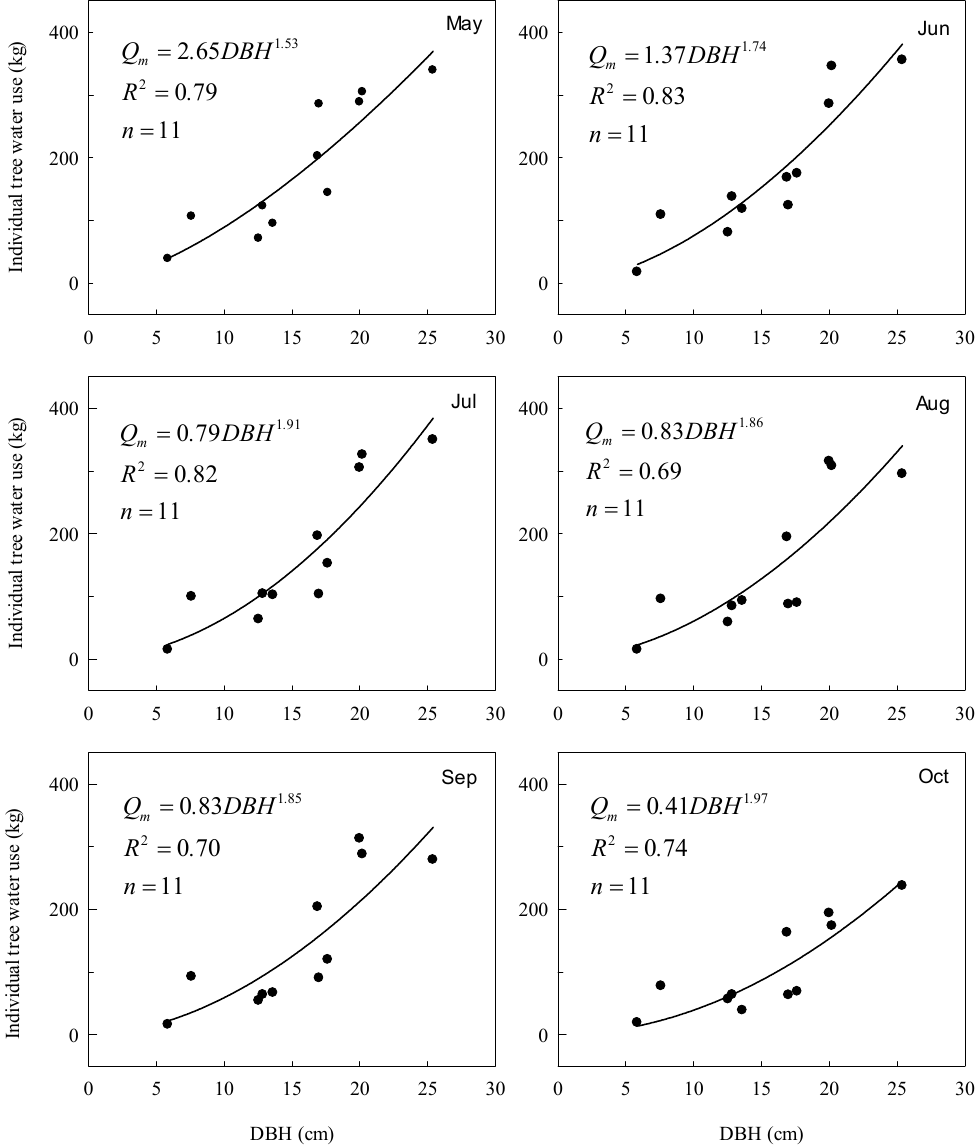
Figure 3. Relationships between monthly individual tree water use of oak trees ( Q m ) and DBH in different months of the 2009 growing season.